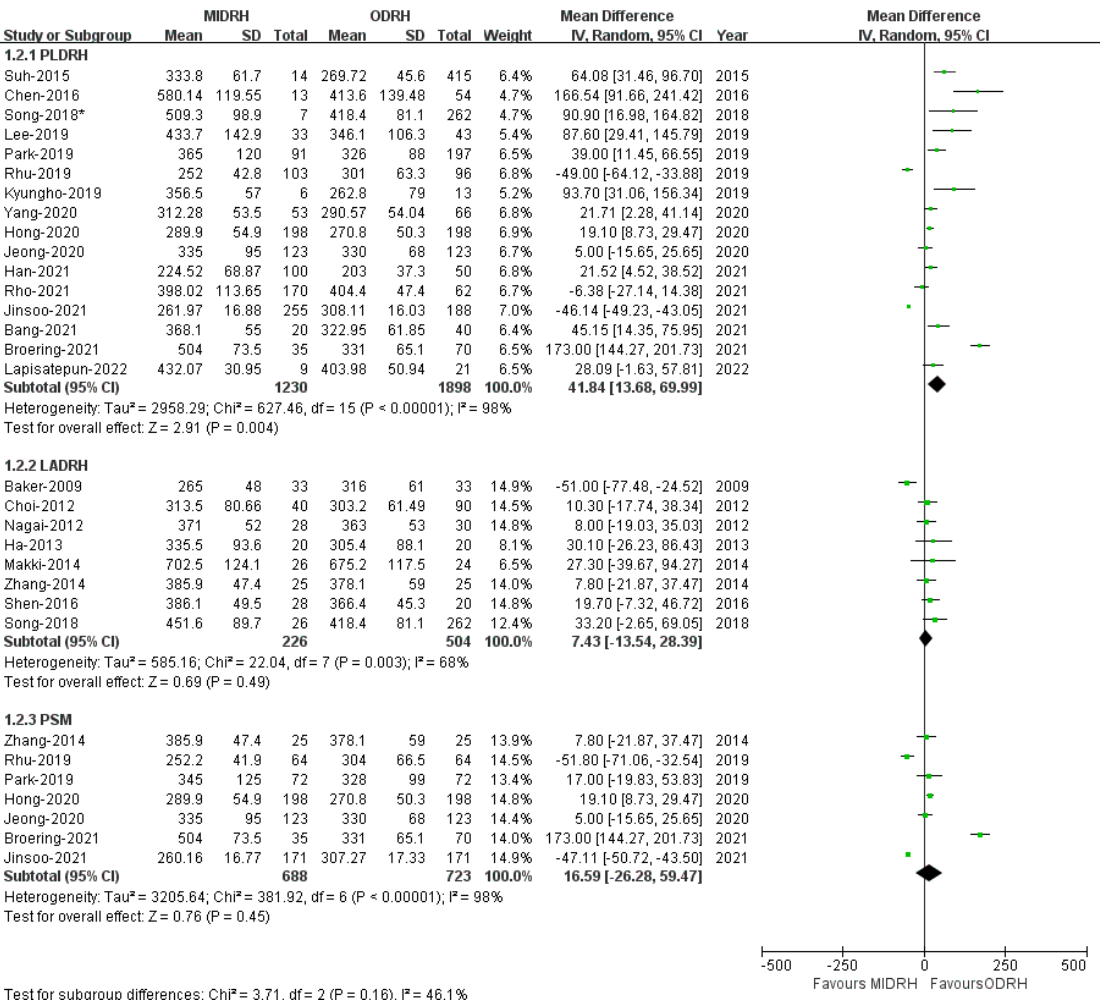
Figure 4. Forest plot comparison of MIDRH versus ODRH for intraoperative blood loss [4–7,12– Figure 5. Forest plot comparison of MIDRH versus ODRH for operative time [4,5,7,12–31]. *: Different 31]. * ： Different data in the same article . data in the same article. *: Different data in the same